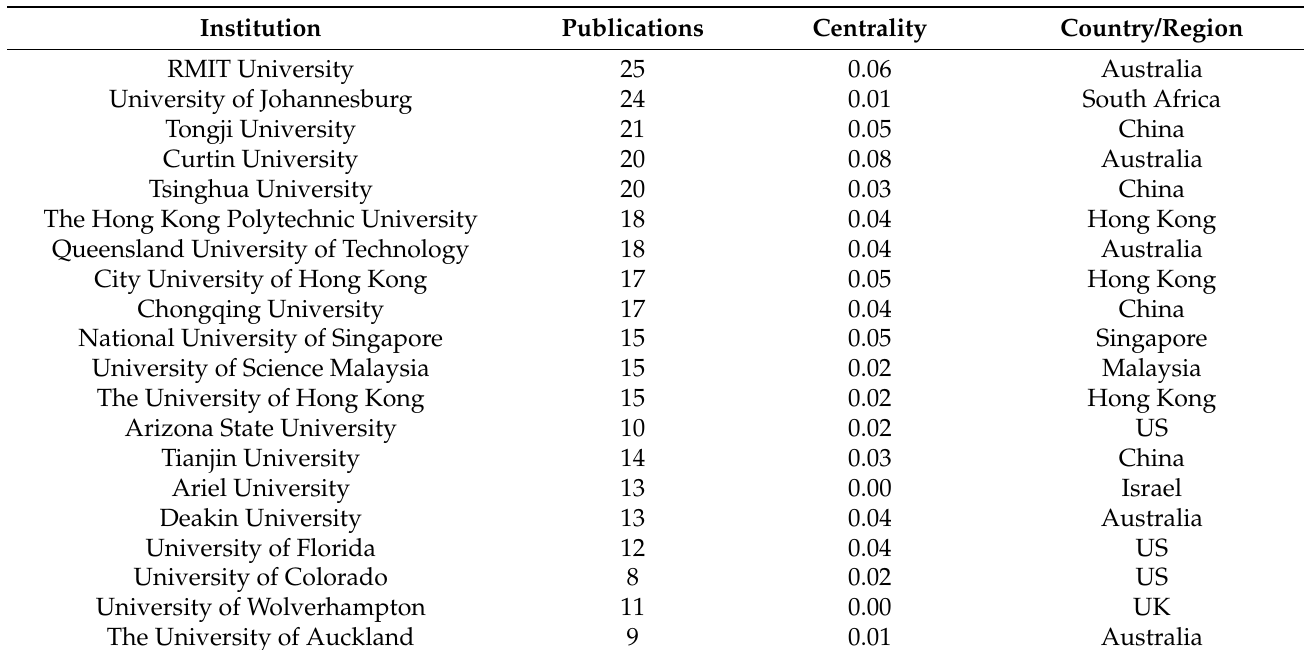
Table 2. Top 20 institutions based on the number of publications.